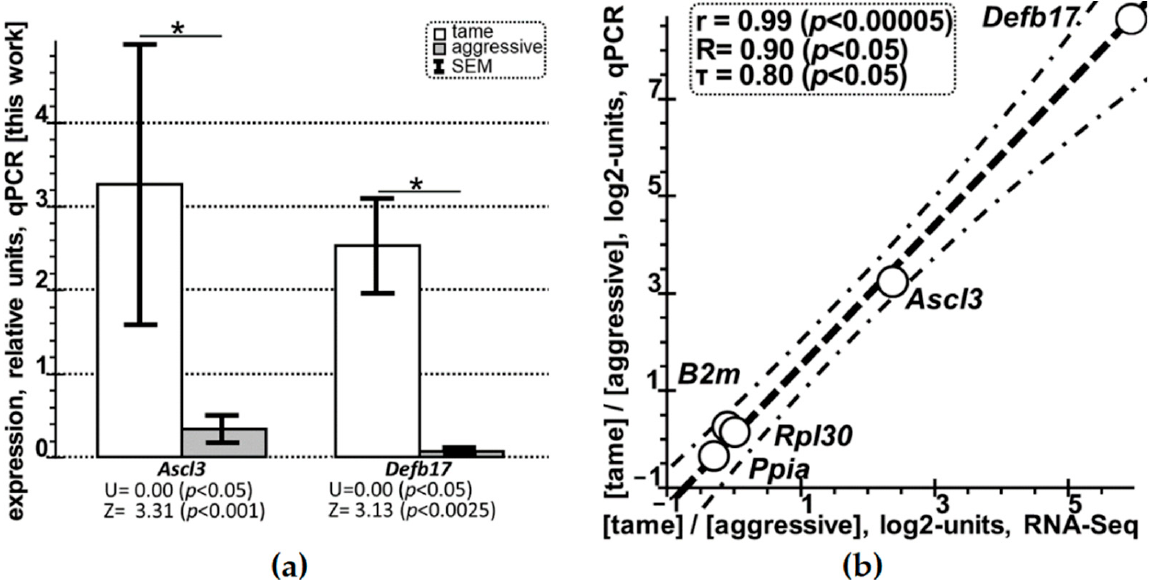
Figure 1. qPCR-based selective verification of the DEGs identified by RNA-Seq in this work in the hippocampus of tame versus aggressive rats. Legend : ( a ) in tame male adult rats (white bars) versus aggressive ones (grey bars), both DEGs examined (i.e., Ascl3 and Defb17 ) are statistically significantly overexpressed in the hippocampus (here, bar height (i.e., mean), error bars (i.e., standard error of the mean [SEM]), and asterisks denote statistical significance at p < 0.05 according to both the nonparametric Mann–Whitney U -test and parametric Fisher’s Z -test). Asterisk (symbol “*”), statistically significant at p < 0.05. ( b ) Statistically significant correlations between the relative expression levels of the two selected DEGs and three reference genes (i.e., B2m ( β -2-microglobulin), Ppia (peptidylprolyl isomerase A), and Rpl30 (ribosomal protein L30)) in the hippocampus of tame versus aggressive rats (open circles), as measured experimentally by RNA-Seq (X-axis) and qPCR (Y-axis) and presented on the log2 scale (see “Materials and Methods”). Dashed and dash-and-dot lines denote linear regression and boundaries of its 95% confidence interval calculated using Statistica software (Statsoft TM , Tulsa, OK, USA). r, R, τ , and p are coefficients of Pearson’s linear correlation, Spearman’s rank correlation, Kendall’s rank correlation, and their p values (statistical significance), respectively.